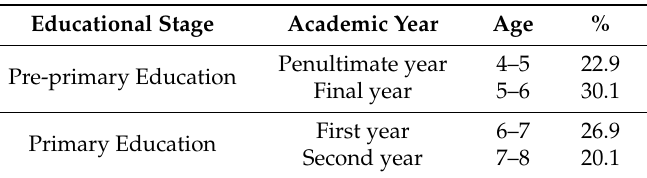
Table 1. Age and academic year distribution of the children comprising the sample at the time when the interviews to the participants were made ( N =